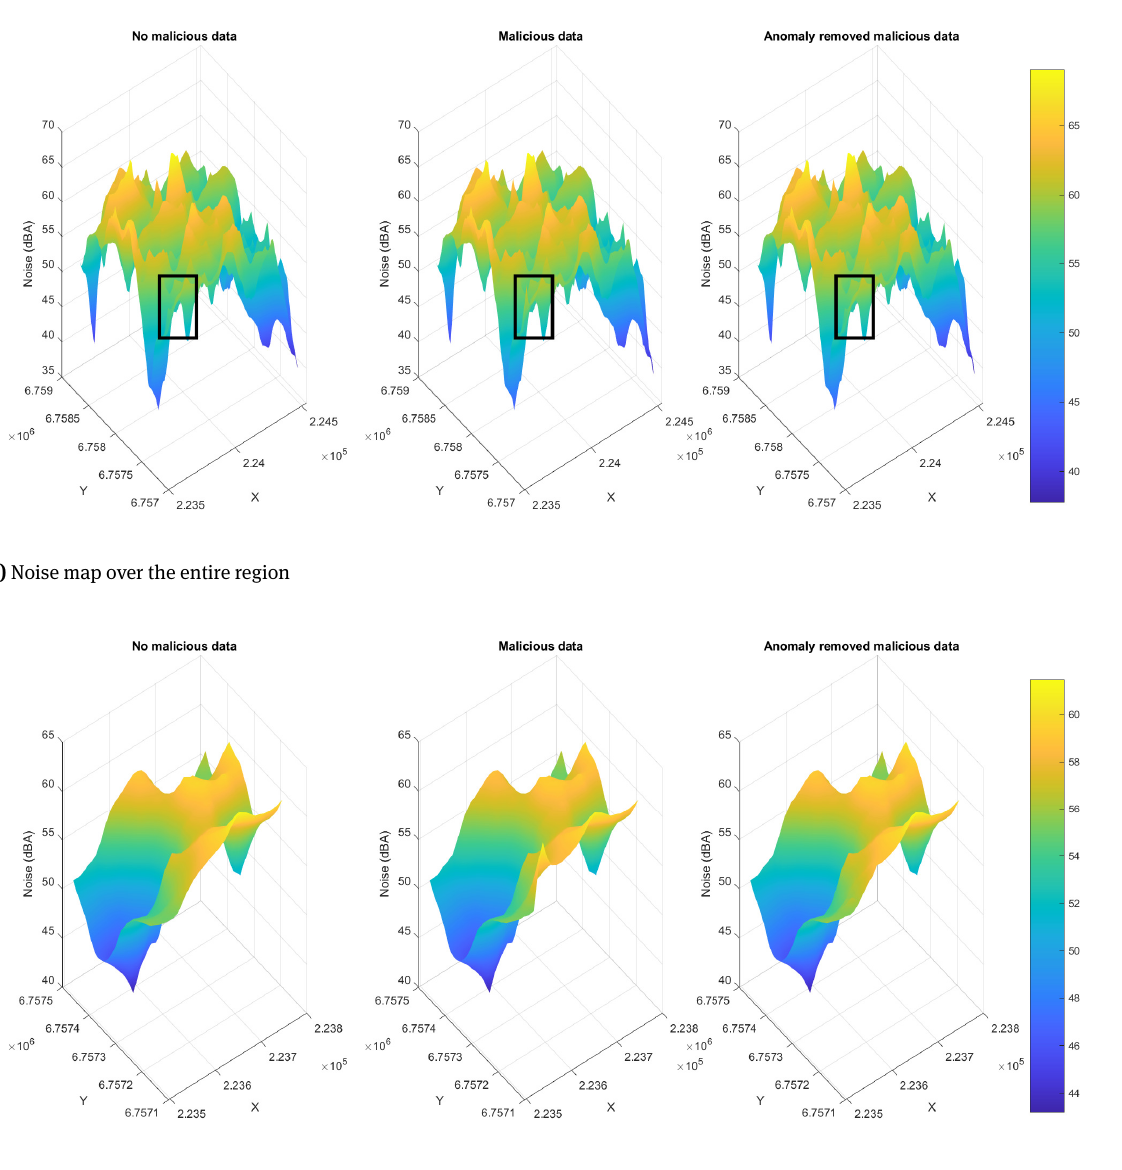
Figure 6: Aggregated noise map generated using no malicious data, malicious data, and anomaly removed malicious data